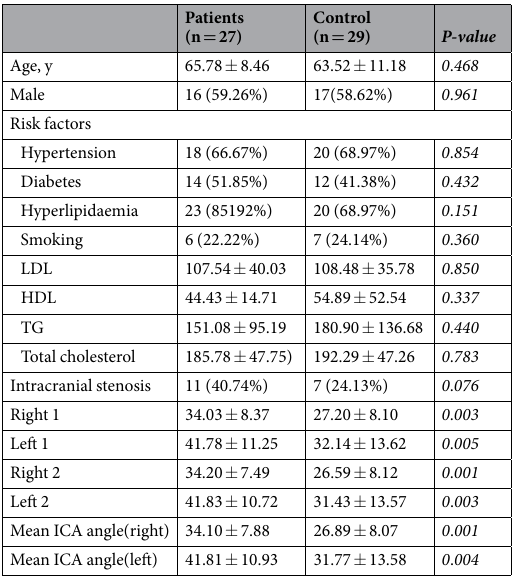
Table 1. Demographics and clinical characteristics. Results are expressed as patients number (%) or mean (standard deviation). LDL: low-density lipoprotein, HD: high-density lipoprotein, TG: triglycerides, ICA: internal carotid artery.